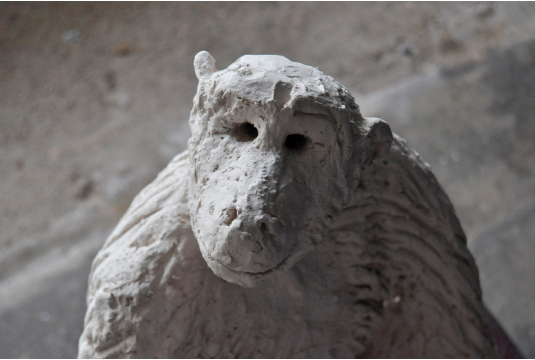
Figure 1. Monkey Business (2018), FILET, London. Ceramic, 50 × 36 × 25 cm. All photos by artist unless otherwise credited.